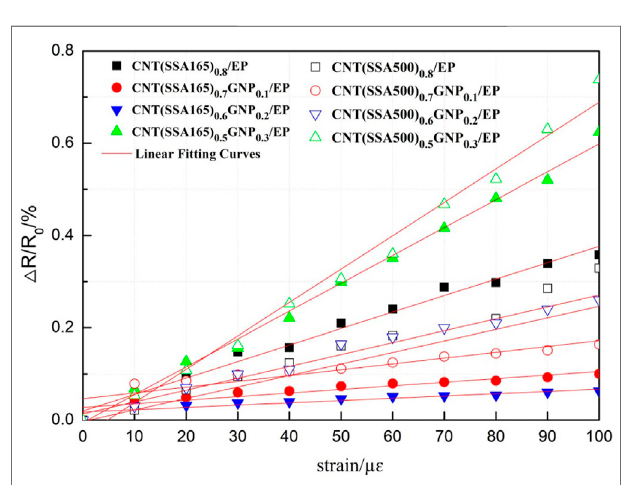
FIGURE 7 | Strain-electrical resistance response peculiarity at strain range of 0-100 µ ε